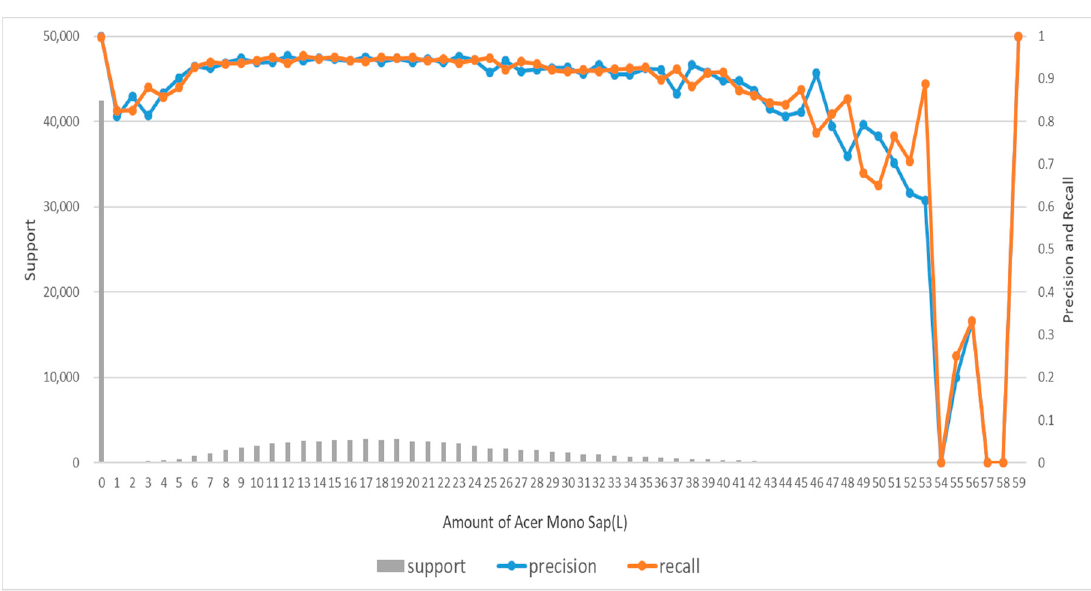
Figure 21. Prediction accuracy of Random Forest optimal model.